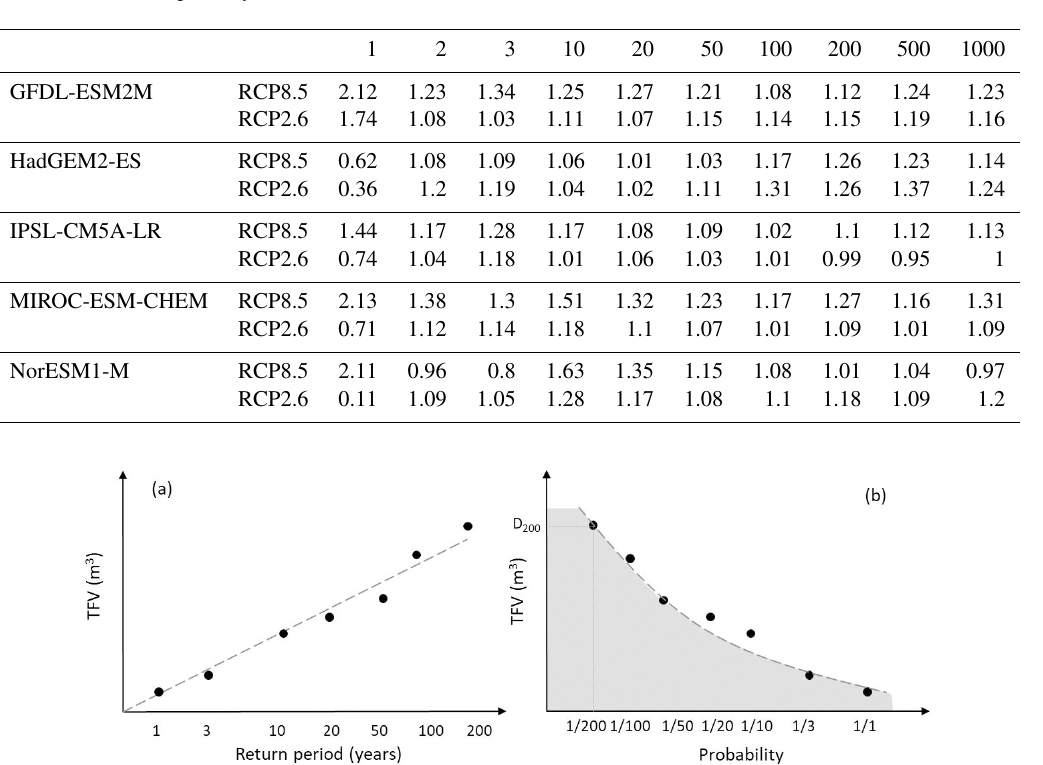
Table 1. Projected changes in precipitation intensity under return periods ranging from 1 to 1000 years by five global climate models under two representative concentration pathways (RCPs).